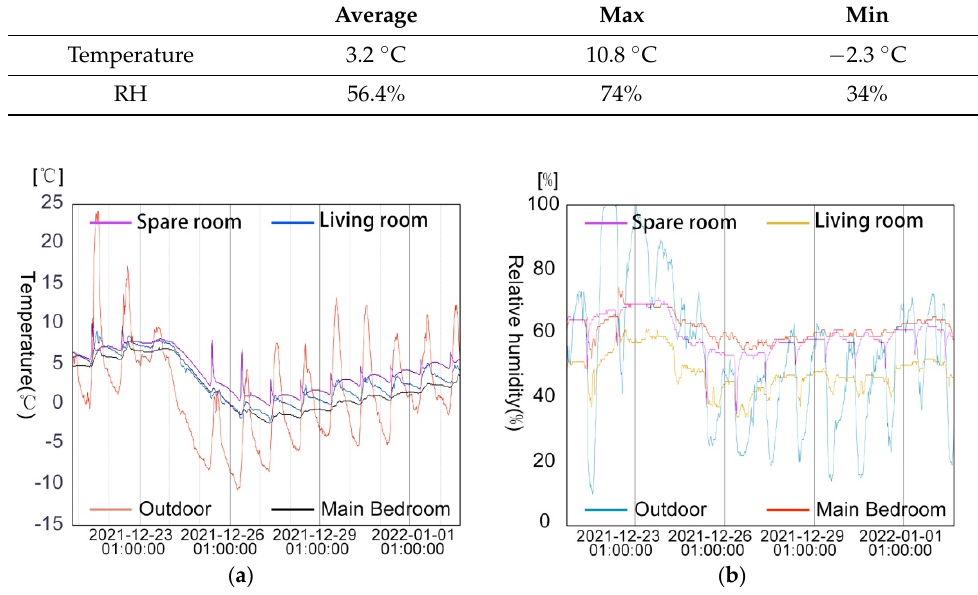
Figure 19. Distribution of indoor environmental parameters for W2: ( a ) air temperature; ( b ) relative humidity. Table 9. Statistics of indoor environmental parameters for W2.